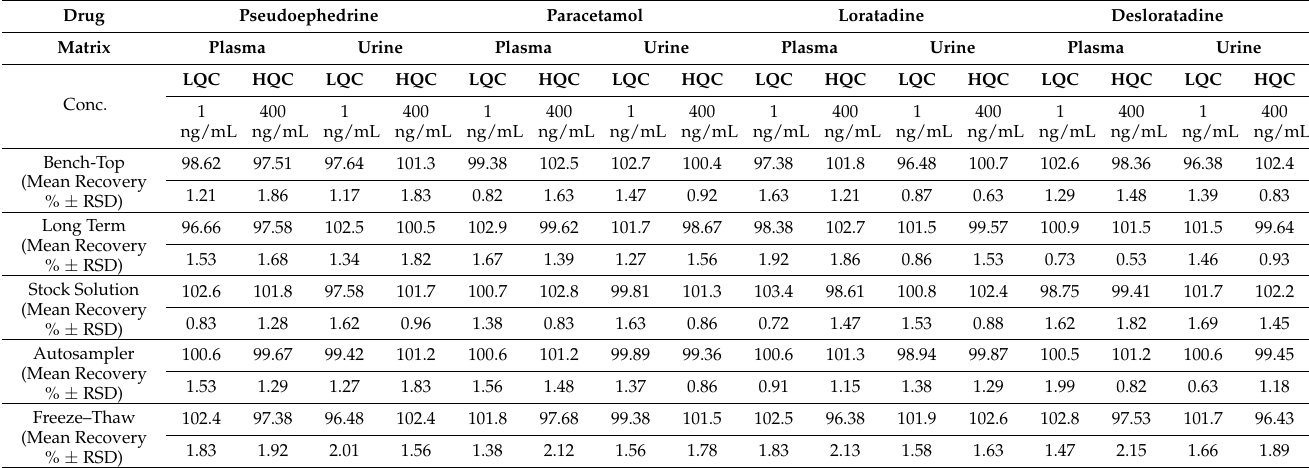
Table 6. Stability of the analytes in different conditions.